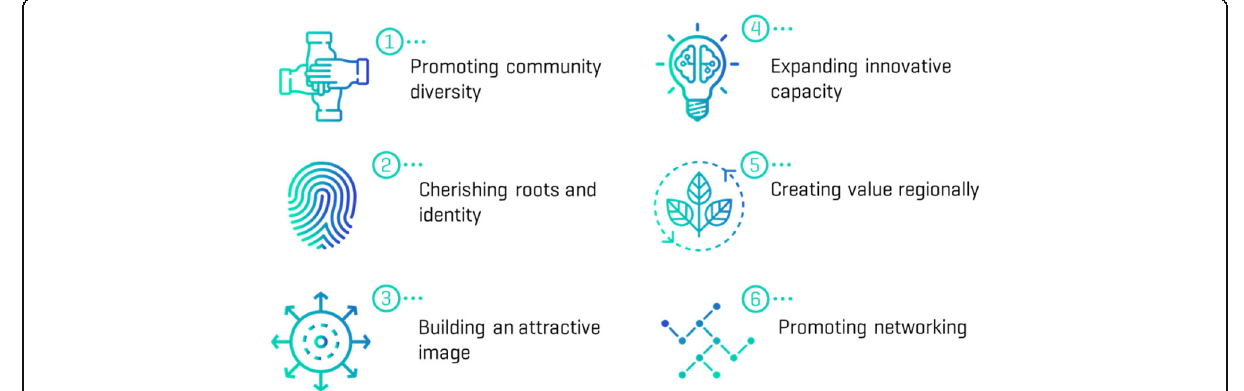
Fig. 5 Fields of action for rural regions © Fraunhofer CeRRI